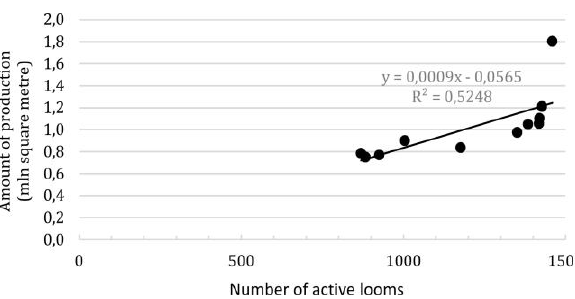
Fig. 3. Number of active PWCS (Chinsurah zone) (Source: Handloom Development Office, Chinsurah, 2018)